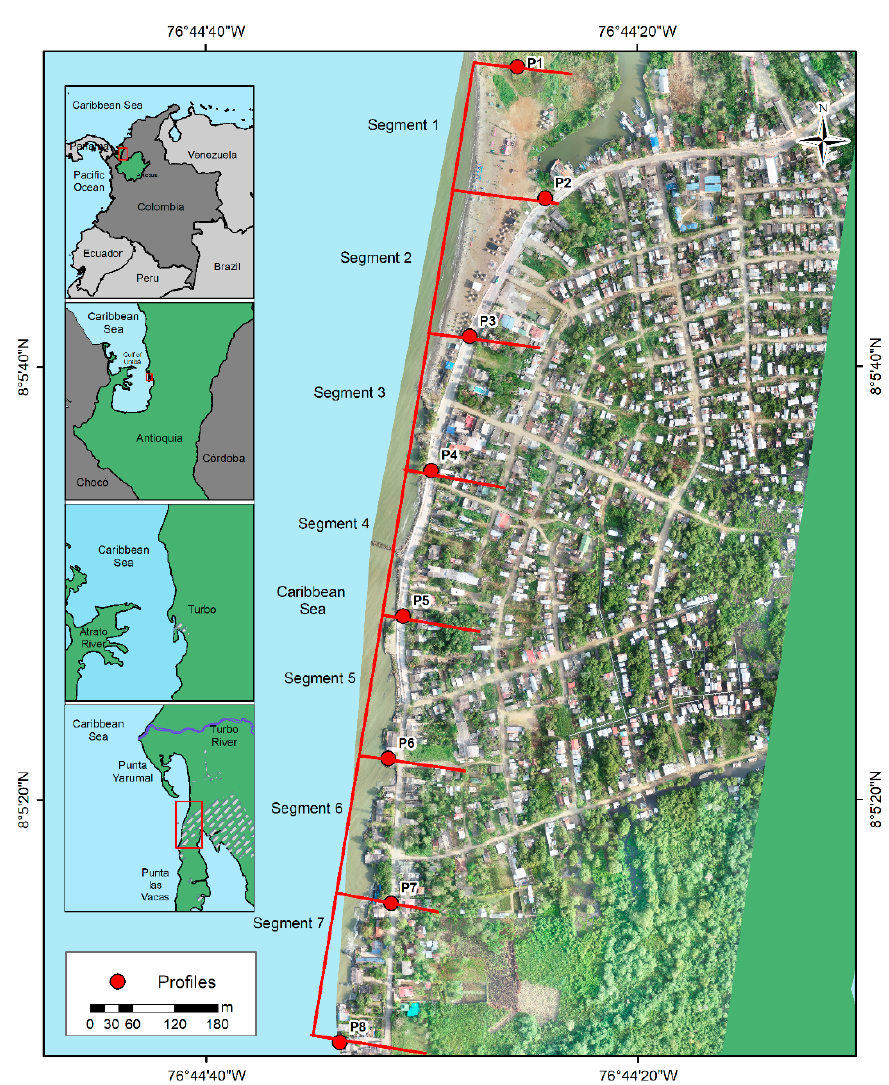
Figure 2. Location of the urban beaches of the Turbo (Antioquia). The red dots show the location of the eight beach profiles. The red lines show the delimitation of the segments.